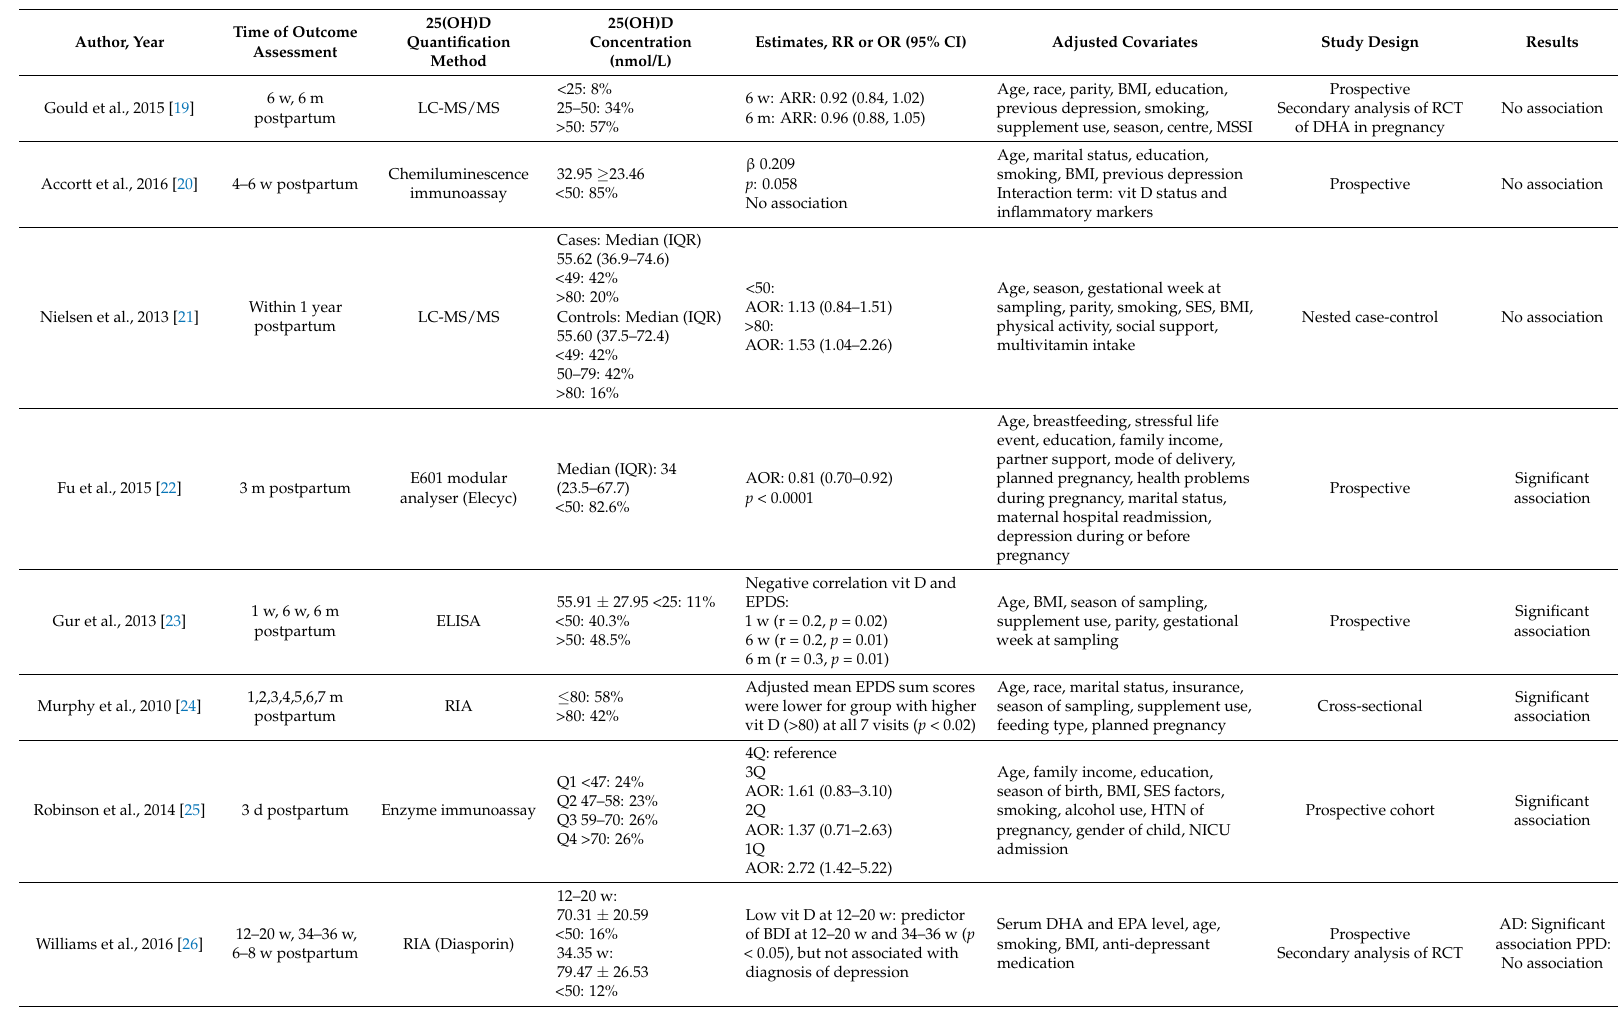
Table 2. Characteristics of included studies